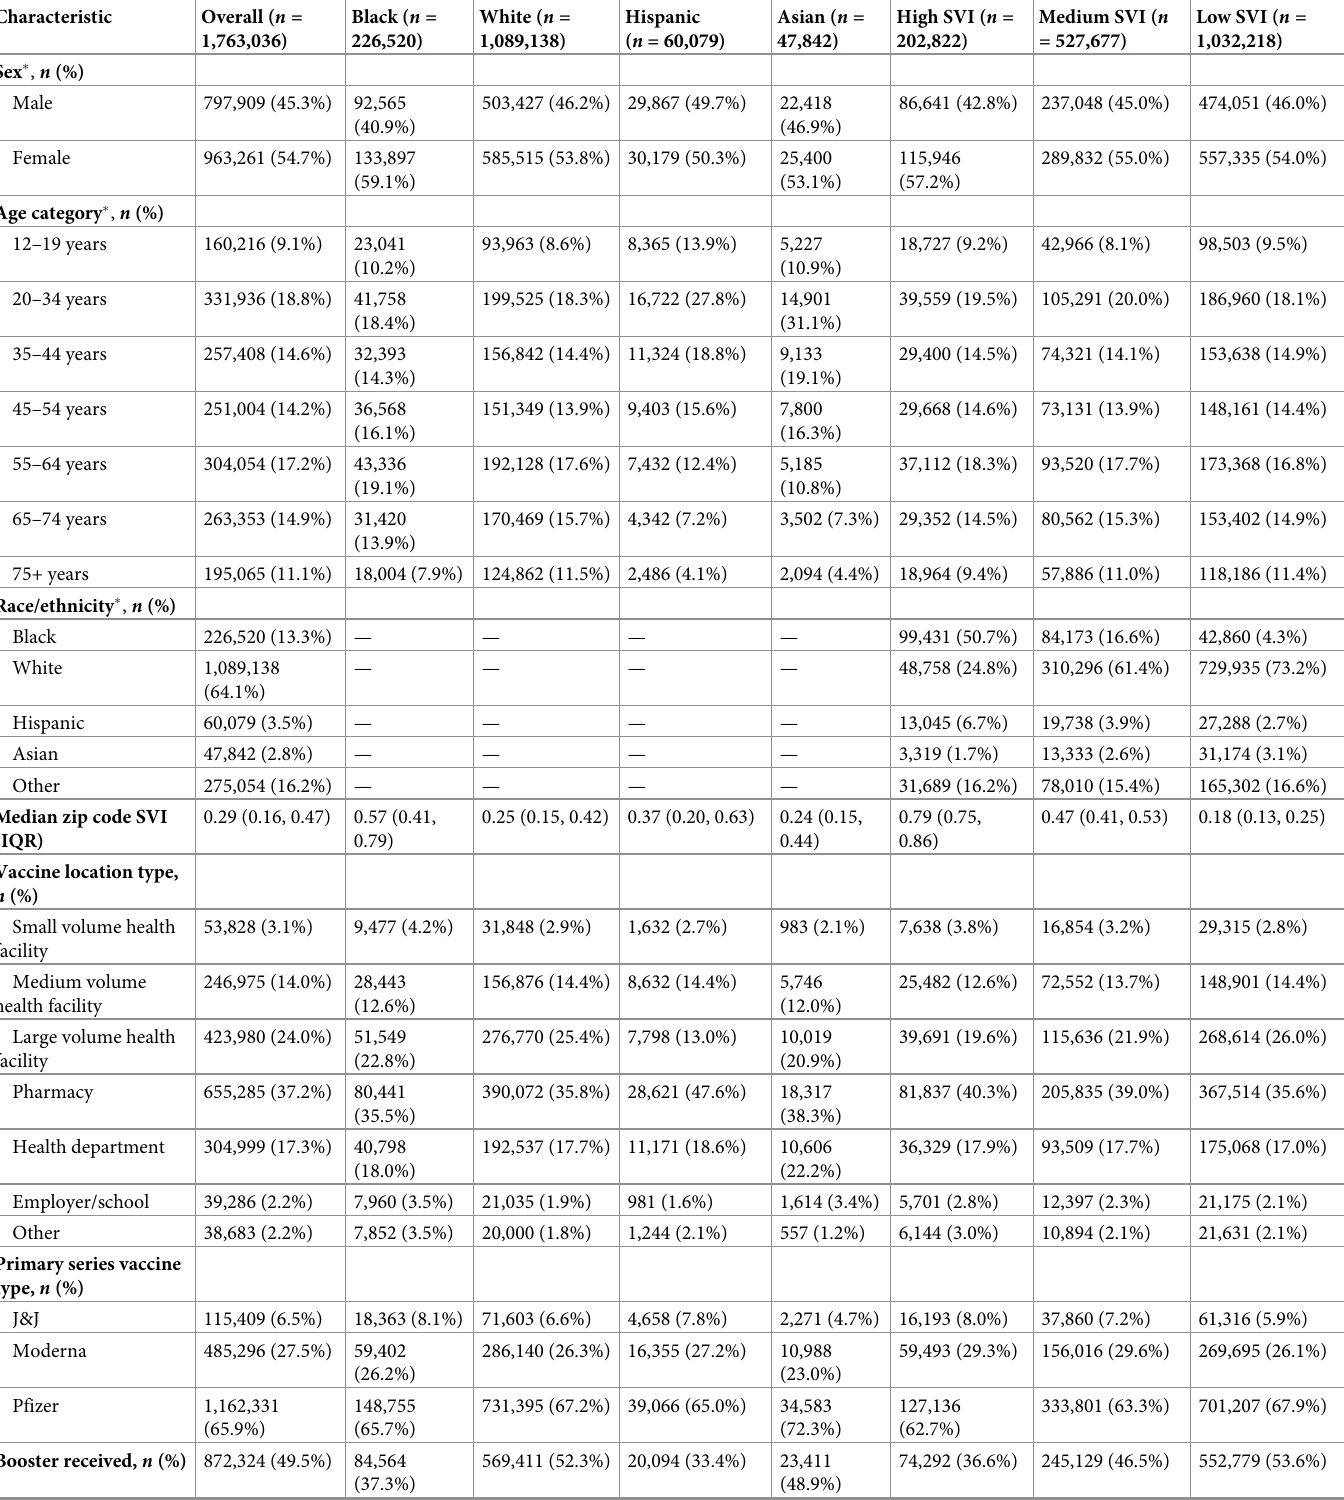
Table 1. Characteristics of individuals completing the primary